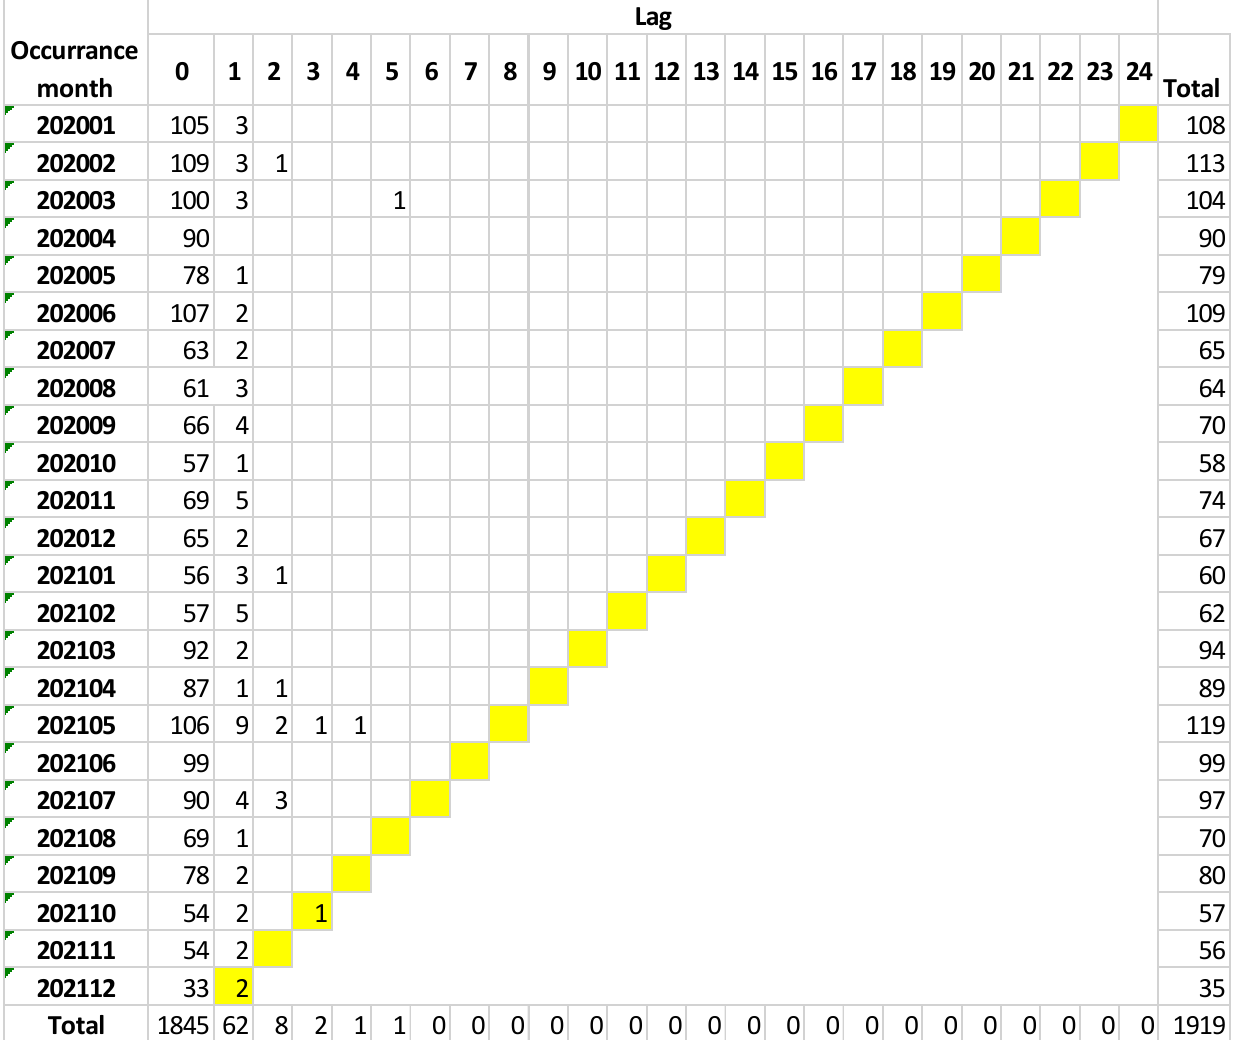
Figure 1. Temporal latency trend related to the occurrence of adverse events.